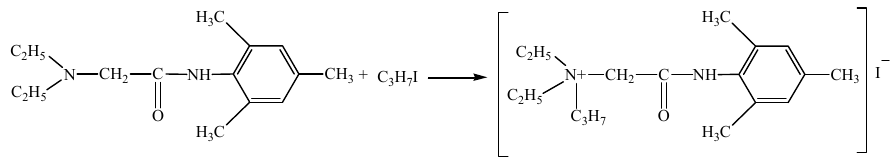
Figure 1. Chemical formation of the trimecaine-based ionic compound.